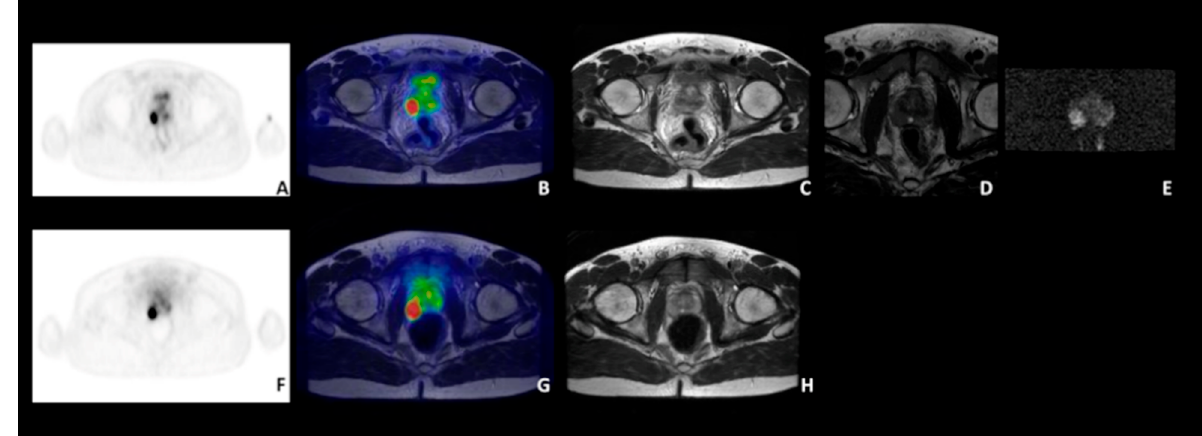
Figure 2. A 53 years-old patient with biopsy-proven PCa (pt n. 10), Gleason score 9 (5 + 4) with a PSA level at diagnosis of 3.13 ng/mL. Concordant 68 Ga-PSMA PET/MRI (top panel; ( A ): transaxial 68 Ga-PSMA PET; ( B ): 68 Ga-PSMA PET/MRI; ( C ): Axial T2-weighted sequence; ( D ): Axial T2-weighted small FOV; ( E ): DWI (b = 1400)) and 68 Ga-DOTA-RM2 PET/MRI (bottom panel; ( F ): transaxial 68 Ga-DOTA-RM2 PET; ( G ): 68 Ga-DOTA-RM2 PET/MRI; ( H ): axial T2-weighted sequence).